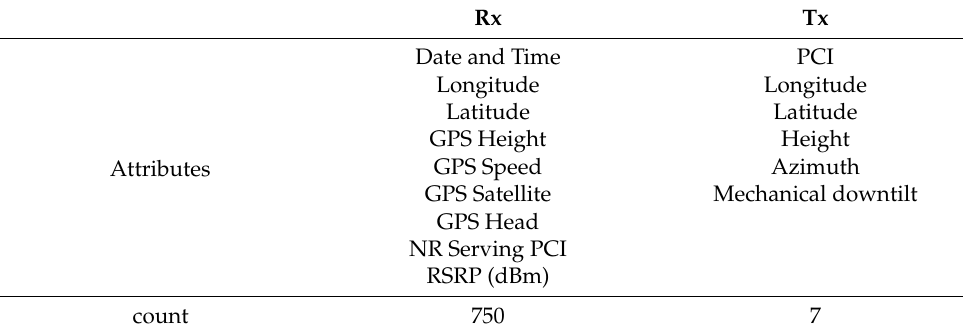
Table 3. The organization of measurement data.